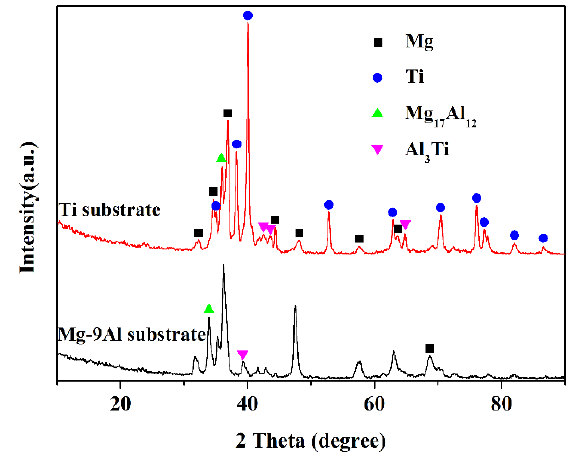
Figure 11. X-ray diffraction patterns form the fractured specimen at 700 °C for 60 min.